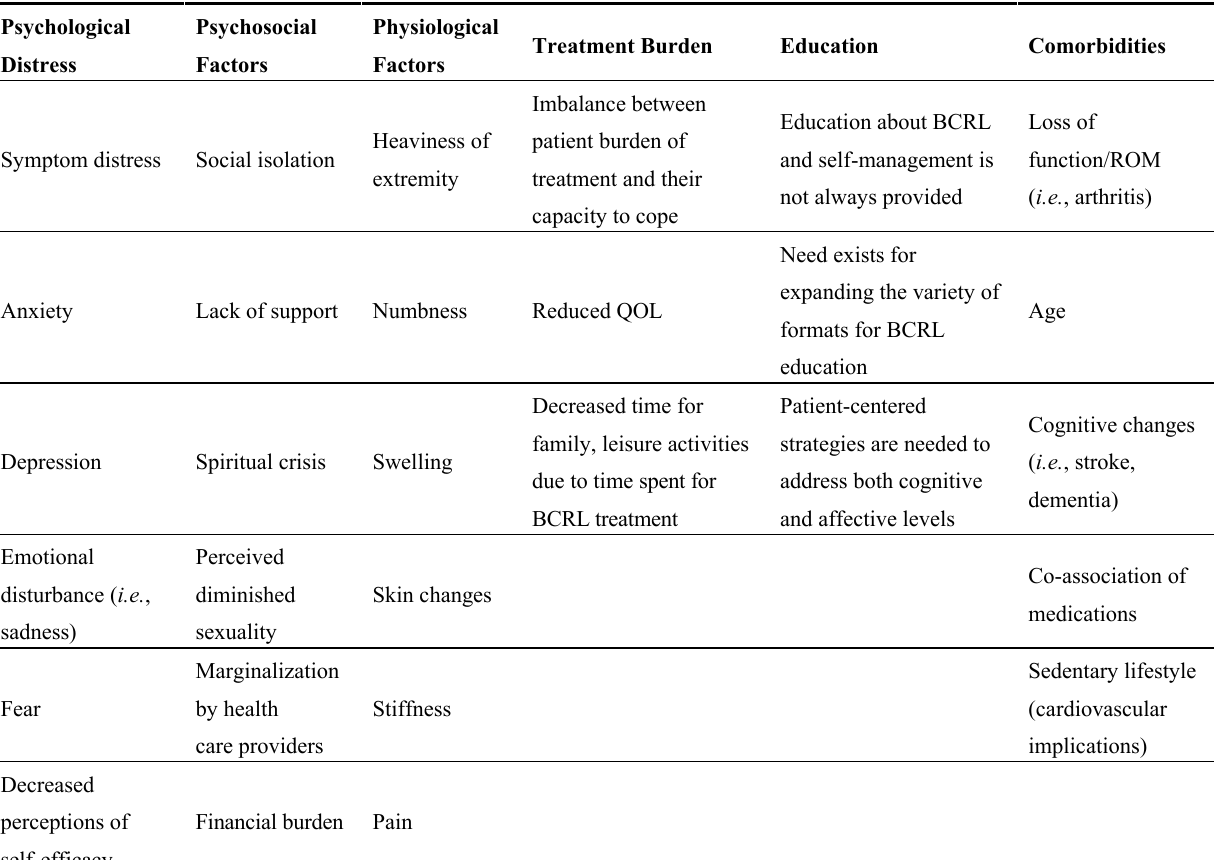
Table 1. Categories of factors related to decreased adherence to breast cancer-related lymphedema (BCRL)